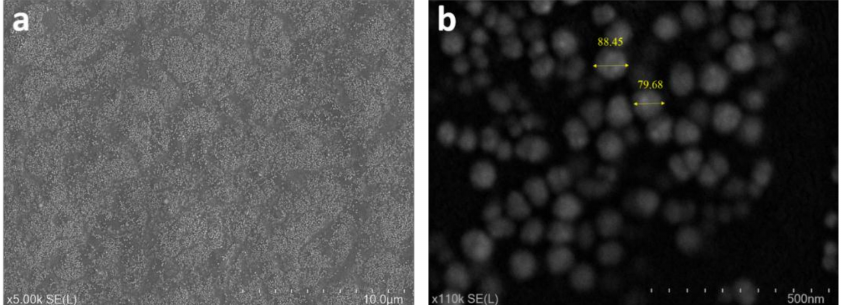
Figure 6. SEM images of ZnO modified T4 plasma polymers at di ff erent magnification of, ( a ) × 5K and ( b ) ×